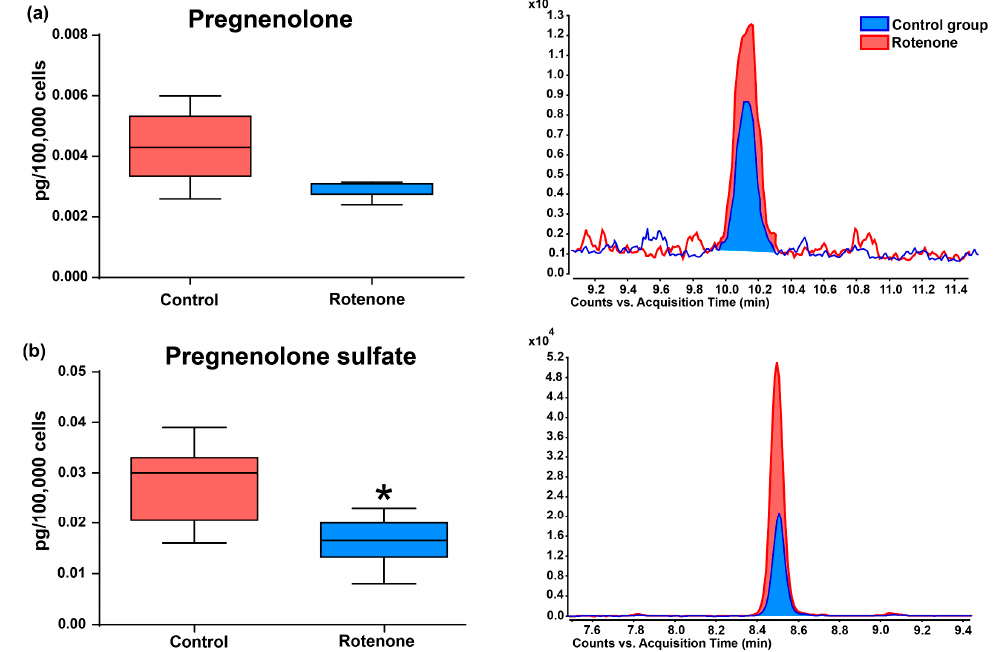
Figure 2. Pregnenolone ( a ) and pregnenolone sulfate ( b ) concentrations in HMC3 cells’ medium determined by LC-MS/MS in microglia in resting condition (Control) or after activation by exposure to rotenone for 24 h. In ( a ), pregnenolone levels, illustrated in the box plot, after stimulation with rotenone were lower but not significantly different when compared to the control group. Peak areas corresponding to the respective median values are illustrated on the right. In ( b ), pregnenolone sulfate levels, illustrated in the box plot, were significantly lower (* p < 0.05, Mann–Whitney rank sum test) after stimulation with rotenone. Peak areas corresponding to the respective median values are illustrated on the right. The neurosteroid concentrations are expressed in pg/100,000 cells.